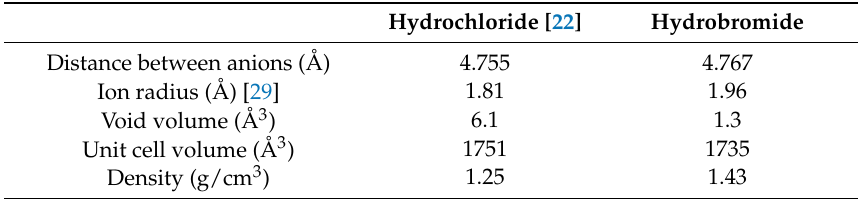
Table 2. Comparison of parameters of the anhydrates of hydrochloride and